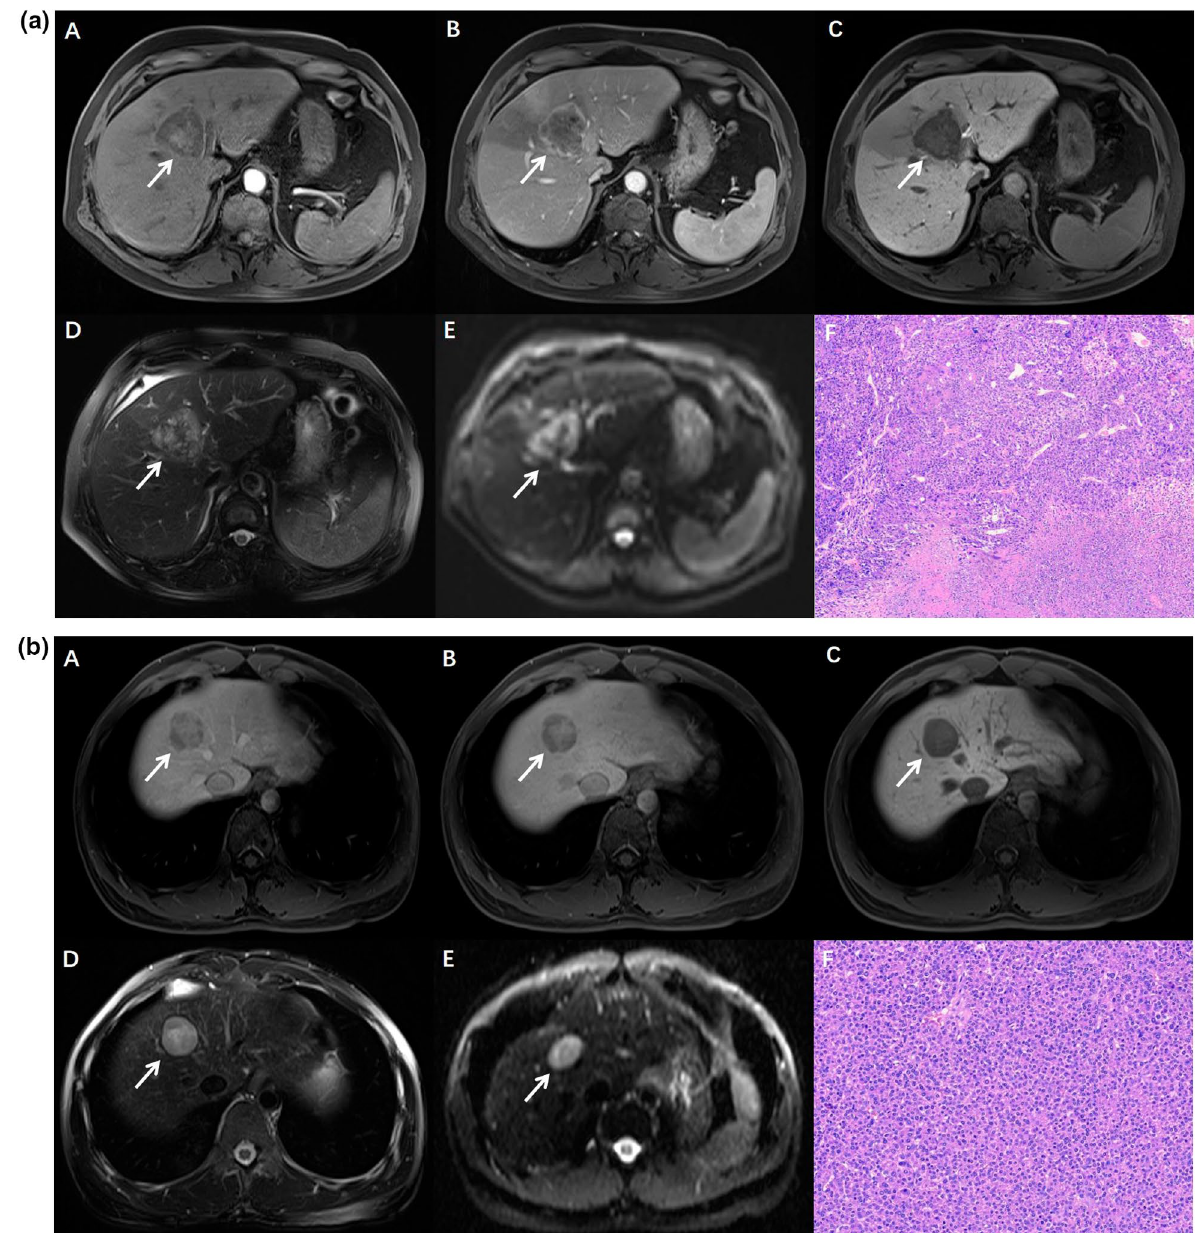
Fig. 3 Typical cases of poorly and moderately differentiated hepatocellular carcinoma (HCC). ( a ) A 61-year-old man with poorly differentiated HCC. (A) Rim hyperenhancement is visible on the arterial phase (arrow). (B) The portal venous phase shows an incomplete enhancing tumor capsule (arrow). (C) The signal intensity of the lesion on the hepatobiliary phase is less than vessels, showing marked hypointensity, and peritumoral hypointensity is also seen on the hepatobiliary phase (arrow). (D) Axial T2-weighted imaging shows a hyperintense signal lesion (arrow). (E) Diffusion weighted imaging shows a marked-restricted-diffusion lesion (arrow). (F) Photomicrograph shows the poorly differentiated HCC (hematoxylin– eosin stain; original magnification, 100). ( b ) A 31-year-old man with moderately differentiated HCC. (A) Non-rim hyperenhancement is visible × on the arterial phase (arrow). (B) The tumor present washout on the portal venous phase (arrow). (C)The lesion shows mild hypointensity on the hepatobiliary phase (arrow). (D) Axial T2-weighted imaging shows a hyperintense signal lesion (arrow). (E) Diffusion-weighted imaging shows a marked-restricted-diffusion lesion (arrow). (F) Photomicrograph shows the moderately differentiated HCC (hematoxylin–eosin stain; original magnification,